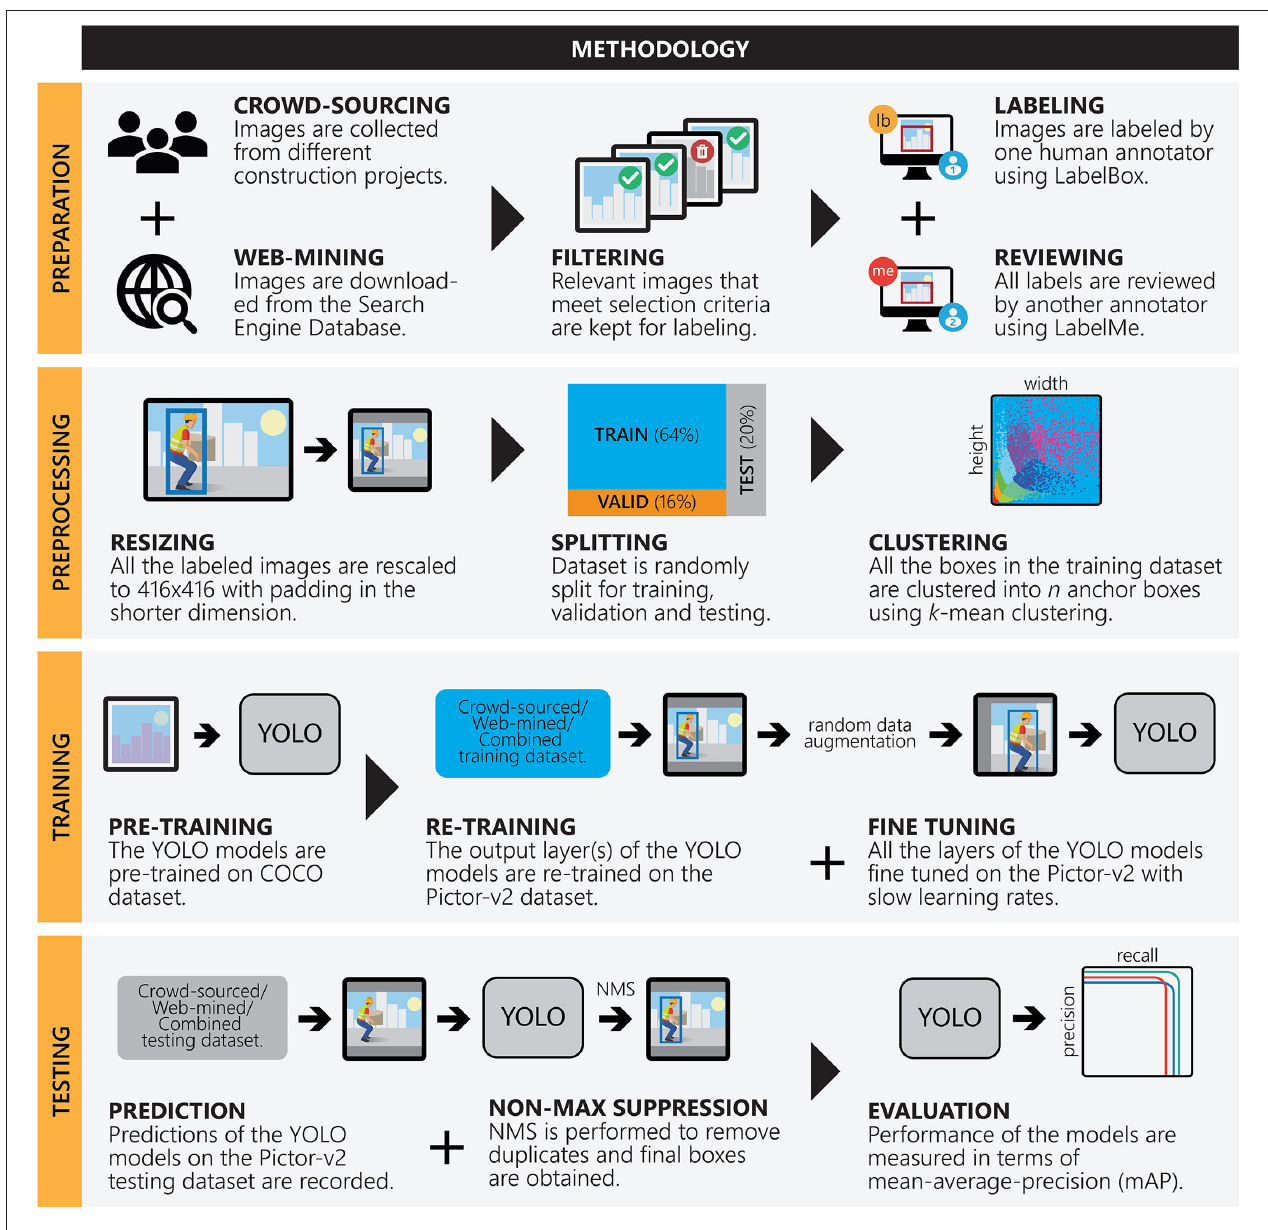
FIGURE 2 | Schematic diagram of the designed